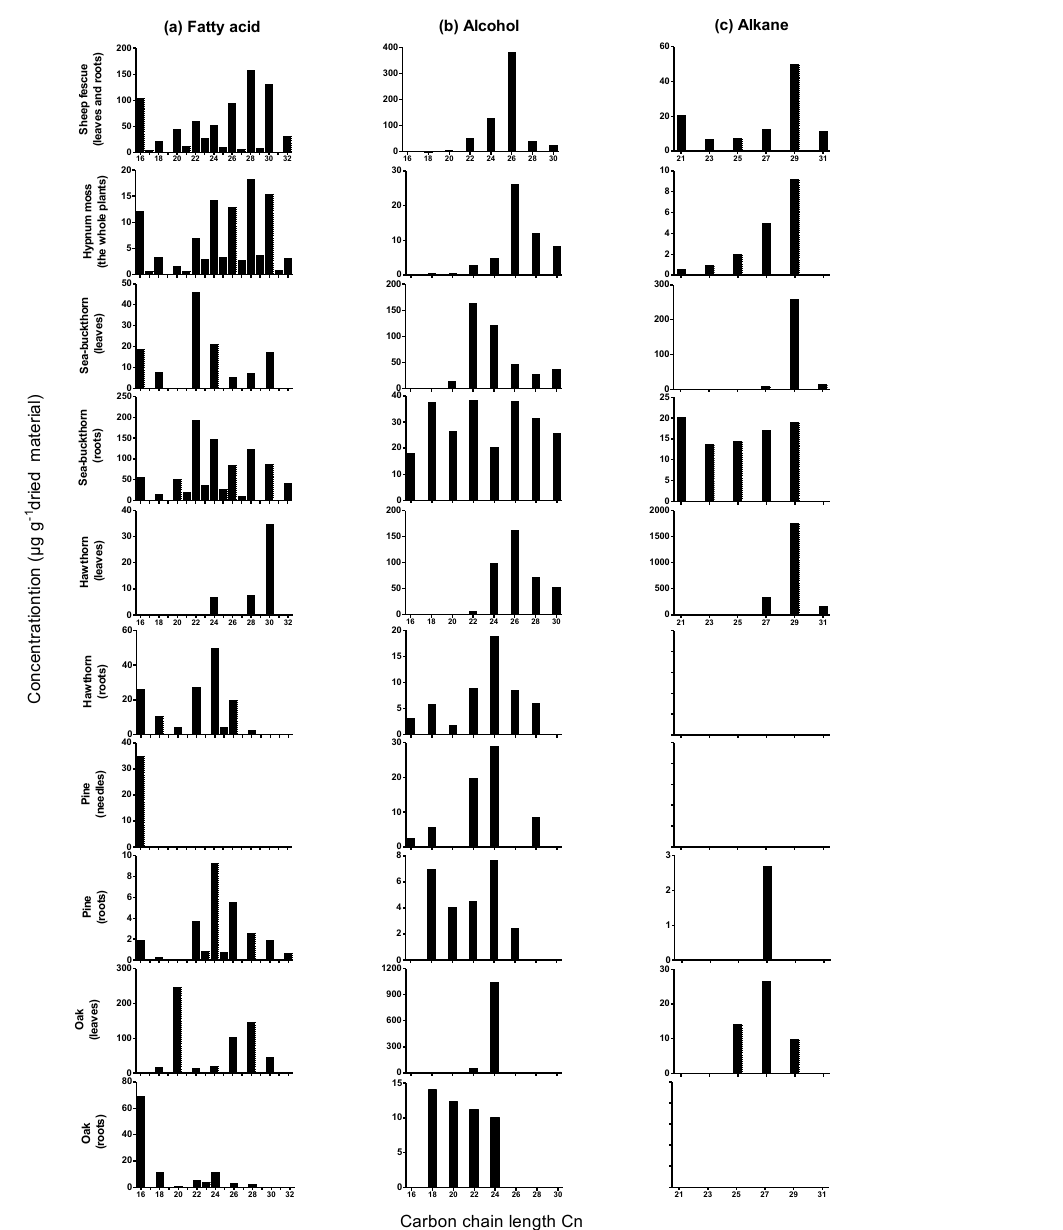
Figure 1. Chain length distribution of DCM/MeOH extractable lipids (µgg − 1 dried material) of vegetation leaves and roots. (a) fatty acids; (b) alcohols; (c)